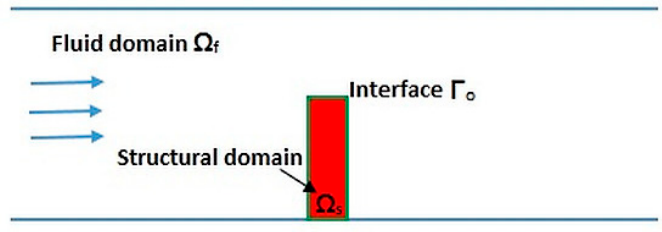
Figure 1. A schematic of FSI in the present work.